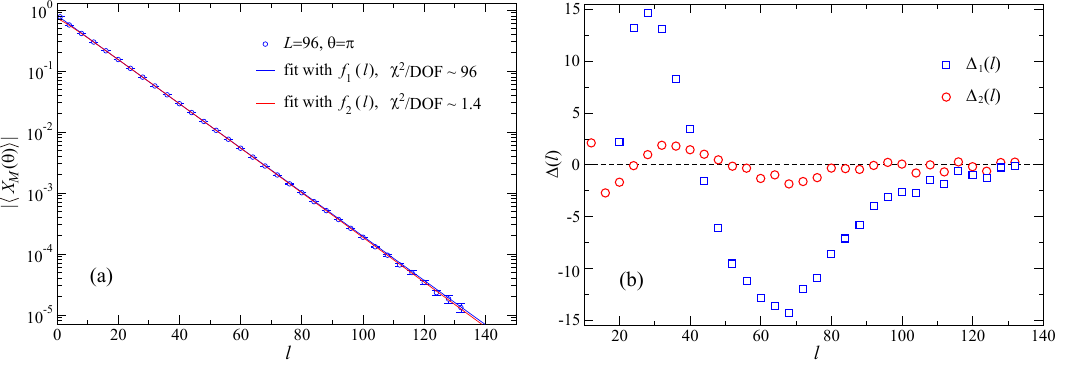
( θ ) 〉| as a function of the perimeter l = 4 R − 4 M model at θ = π . The difference in the bilayer ( l ) = ( X ( l ) − f ( l )) /δ , with δ being the error m X M ( l ) X M ( l ) 1 ( 2 ) 1 ( 2 )